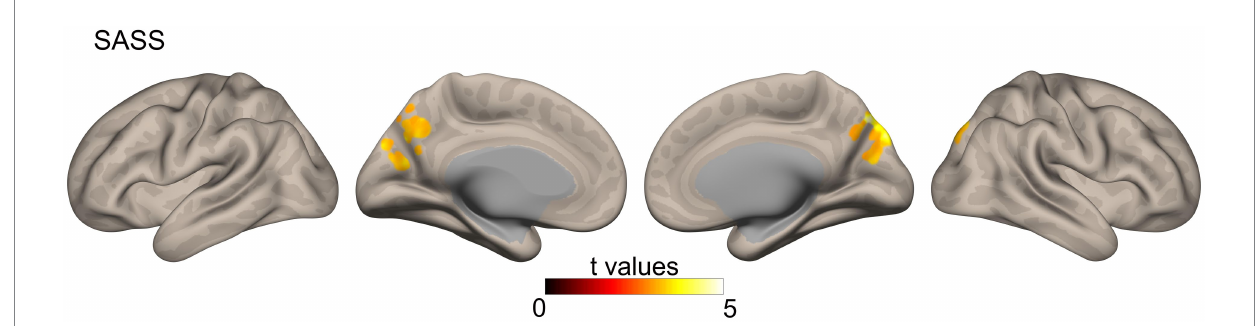
FIGURE 2 Functional connectivity correlates of SASS were calculated from a resting-state functional MRI sequence using a global correlation (connectivity between a specific voxel and the rest of the brain, measured through the average of their Pearson correlation coefficient r ). Results were corrected with Gaussian random field theory (cluster size threshold: p < 0.05 FDR corrected, voxel threshold at p < 0.001 uncorrected). SASS, social adaptation self-administered